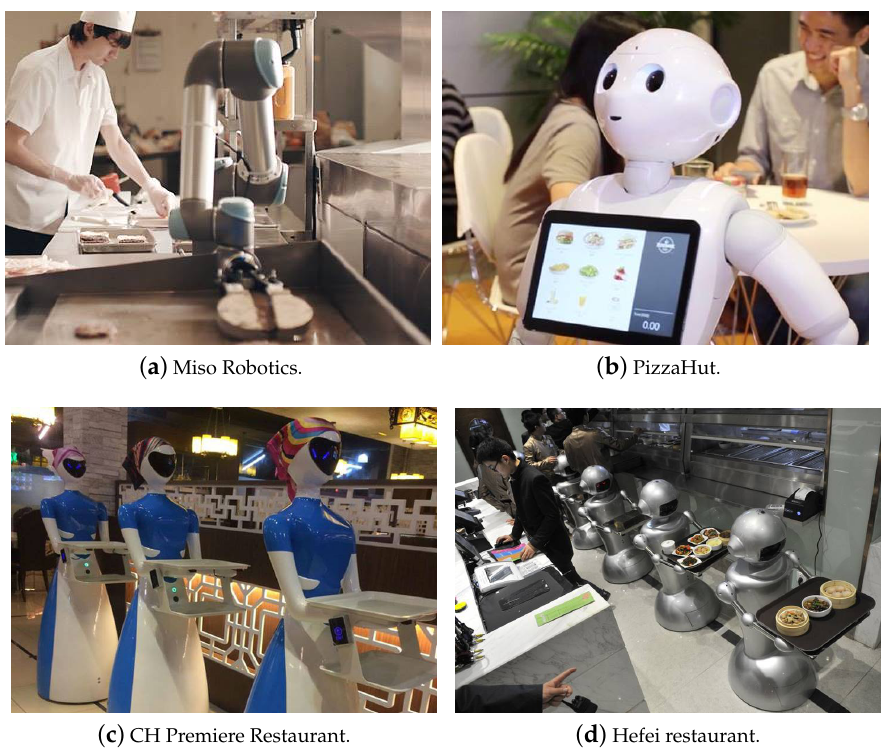
Figure 4. Different examples of service robots working in a restaurant or in a kitchen nowadays. ( a ) Chef robot from MISO ROBOTICS. ( b ) Robot Pepper in a PizzaHut restaurant. ( c ) Robot Collection from CH Premiere Restaurant (Malaysia). ( d ) Robot platoon from Hefei restaurant